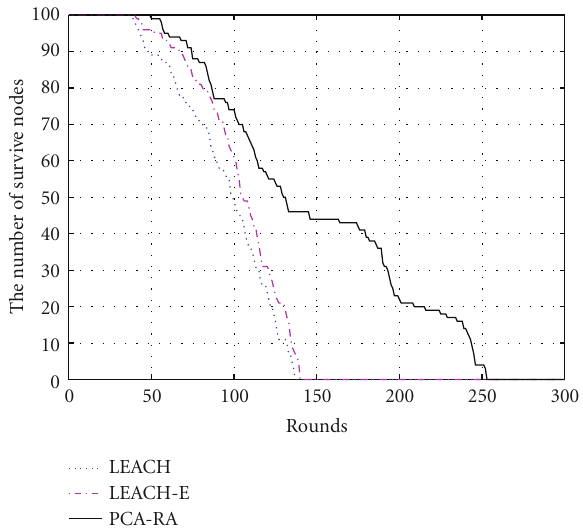
Figure 7: System lifetime using LEACH, LEACH-E and PCA-RA.